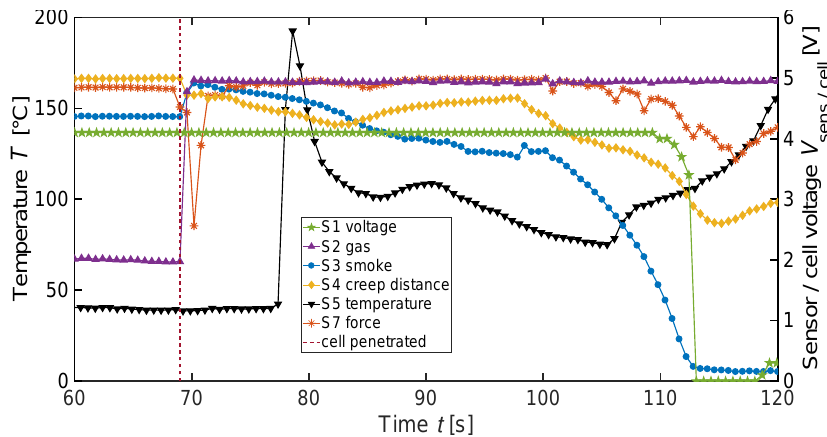
Figure 3. Sensor readings during test V2. The dashed line indicates when the trigger cell is fully penetrated. The detection time window is about t detecWin ≈ 44s wide, mainly stretched by the late drop in the cell